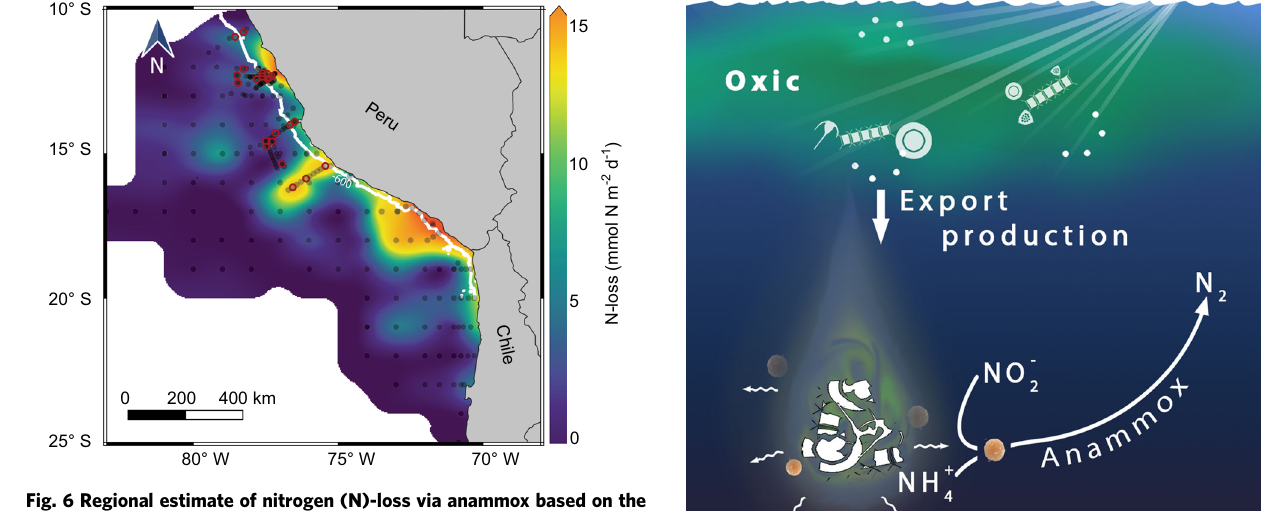
Fig. 6 Regional estimate of nitrogen (N)-loss via anammox based on the volume of small particles (128 – 256 µ m). Anammox rates in the anoxic water column of Peruvian oxygen minimum zone (O 2 < 1.5 µ M) derived from UVP measurements carried out from March to July 2017 (black circles depict UVP casts during cruises M135 – M138). Extrapolating these rates over a whole year would lead to a nitrogen loss of around 19 Tg. The red circles depict stations where the anammox rates were measured. The white line is the 600 m